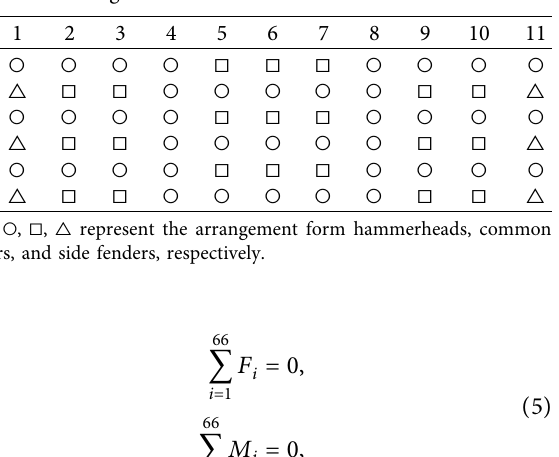
Table 3: Arrange form of the hammerheads and the